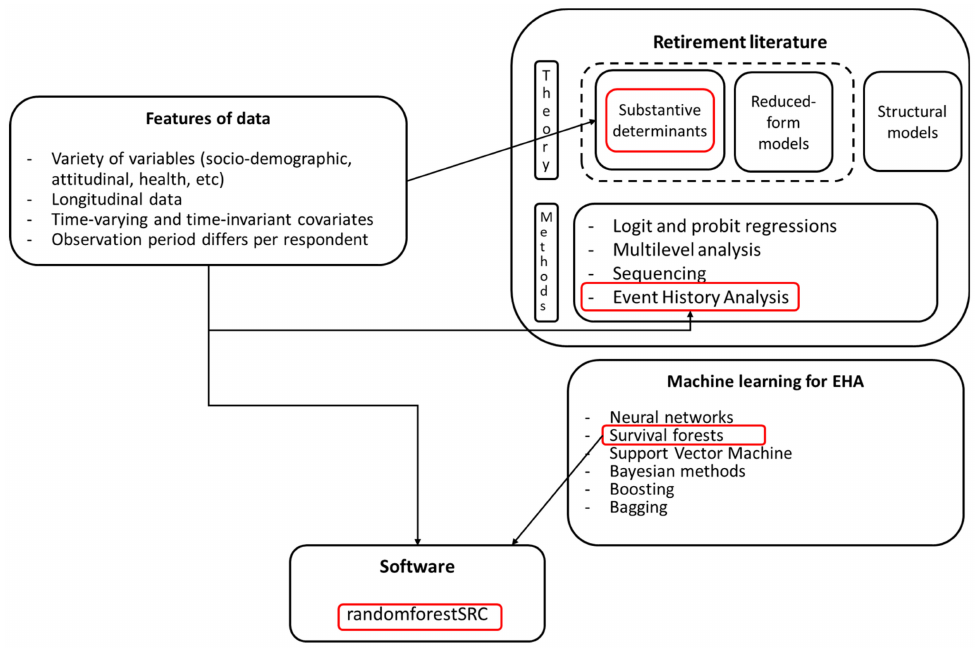
Figure 1. Schematic summary of the literature